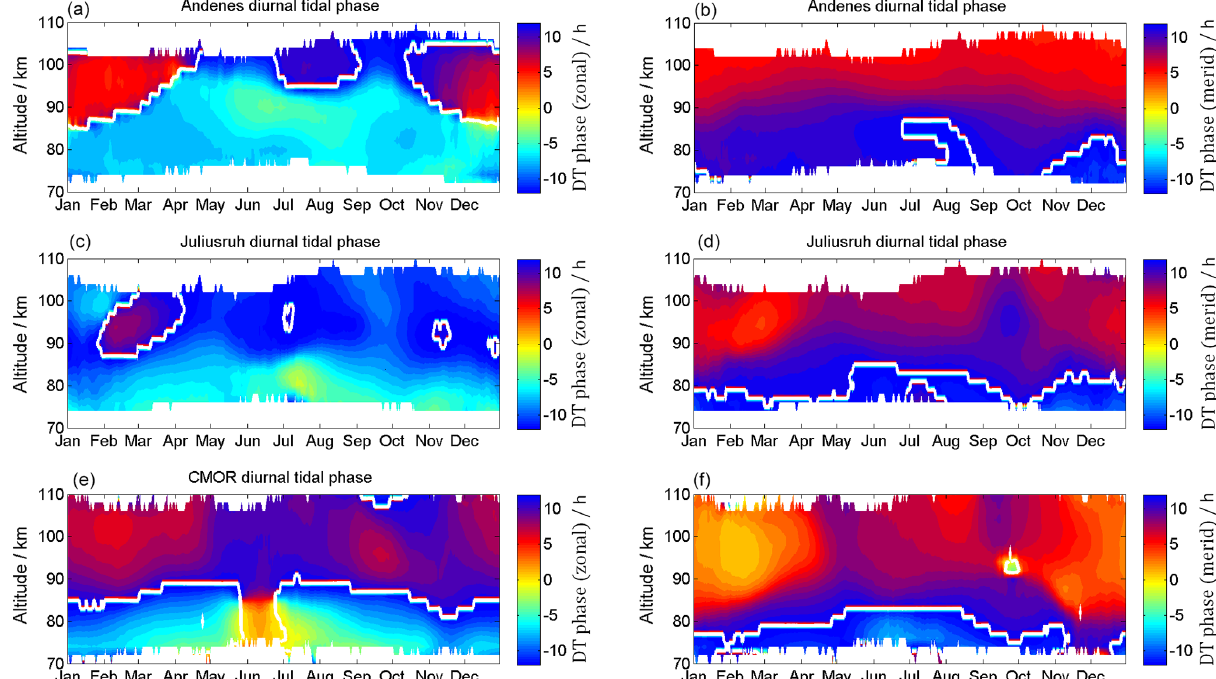
Figure 9. Composites of the zonal (a, c, e) and meridional (b, d, f) diurnal phase information for Andenes (a, b) , Juliusruh (c, d) , and CMOR (e, f)